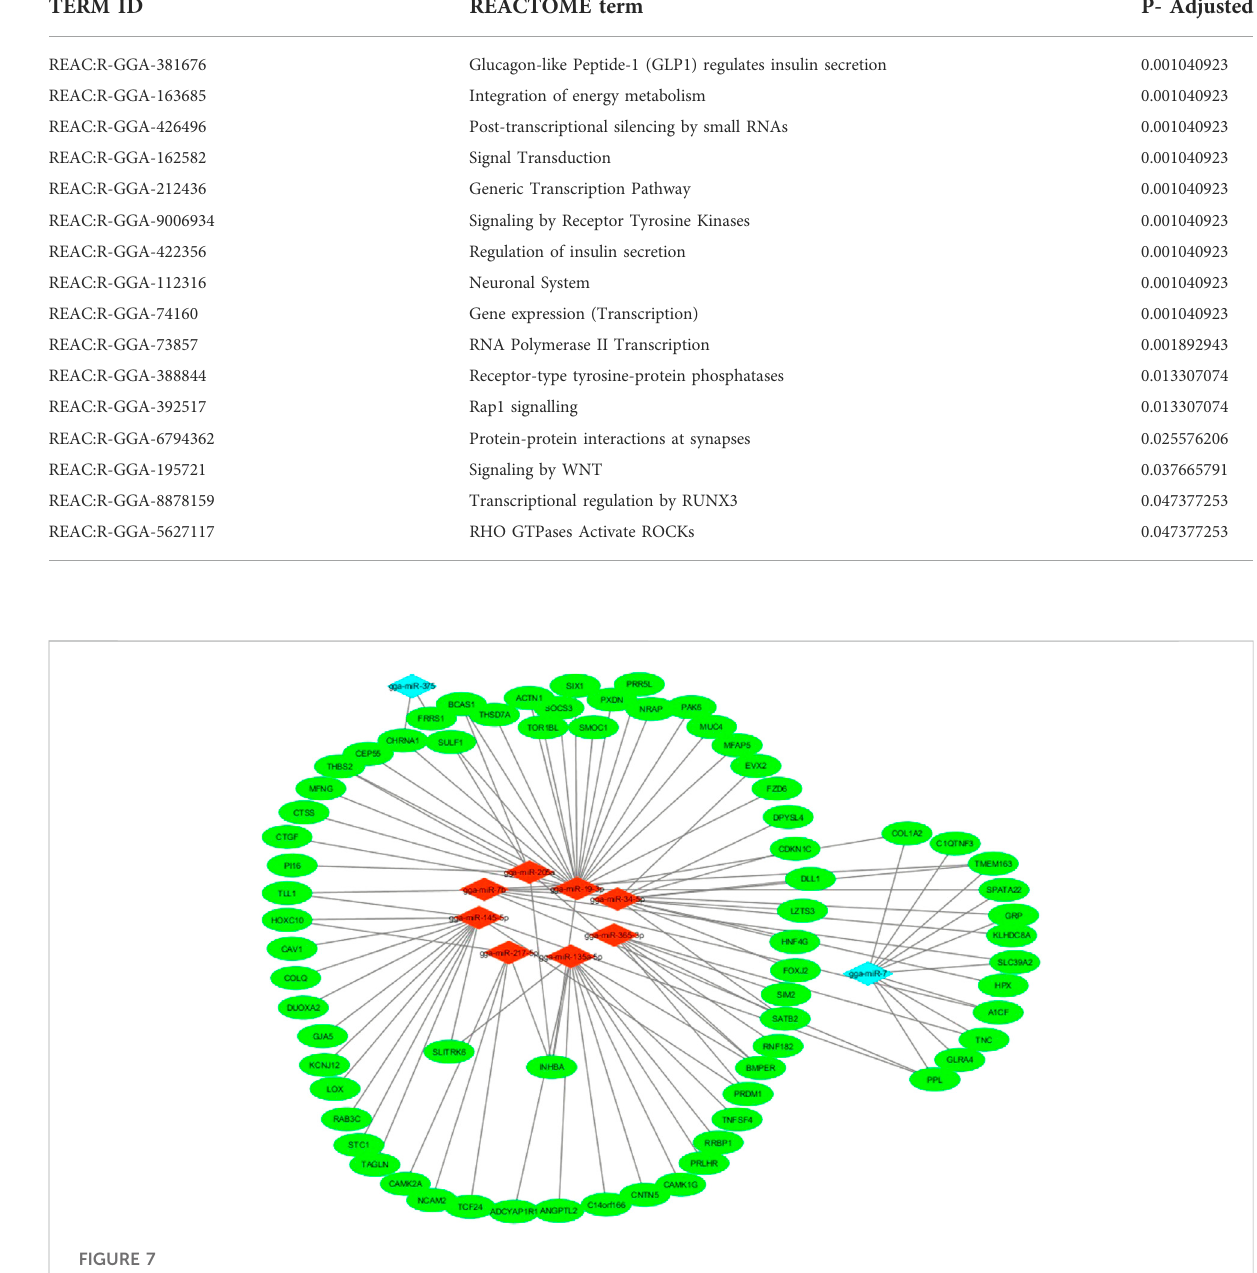
TABLE 4 REACTOME terms enriched by target genes of miRNAs with non-additive modes of expression in crossbred laying hens. TERM ID